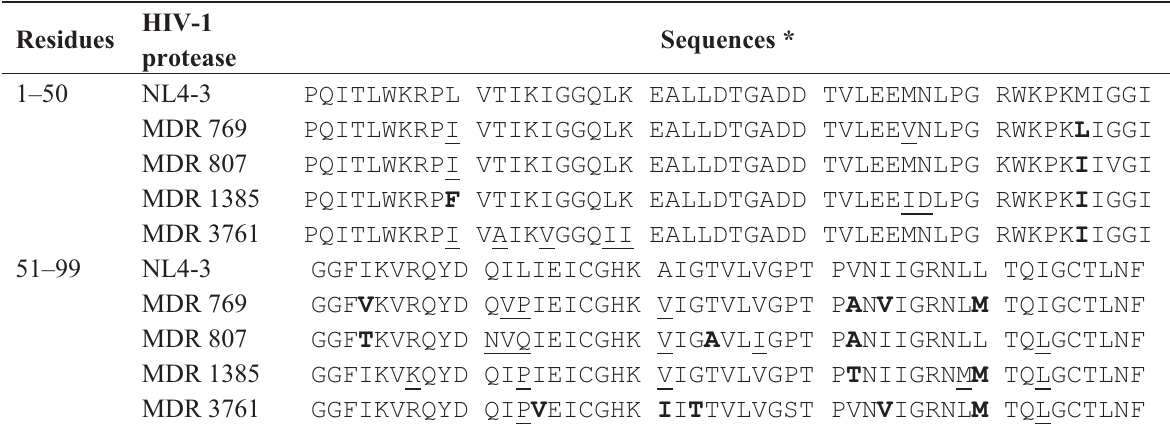
Table 5. Sequences of HIV-1 protease